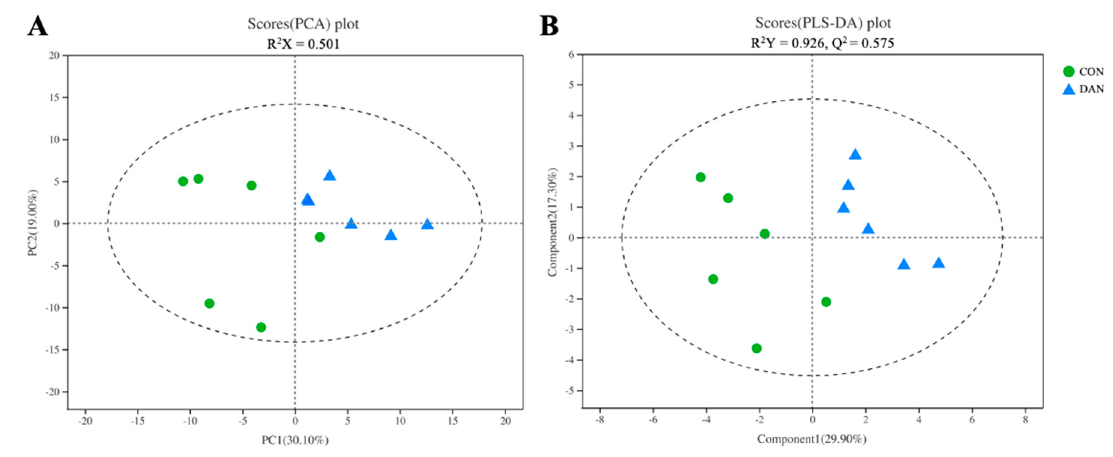
Figure 5. The principal component analysis (PCA) ( A ) and partial least squares discriminant analysis (PLS-DA) ( B ) score map derived from the GC-TOF/MS metabolites profiles of rumen fluid in the CON and DAN